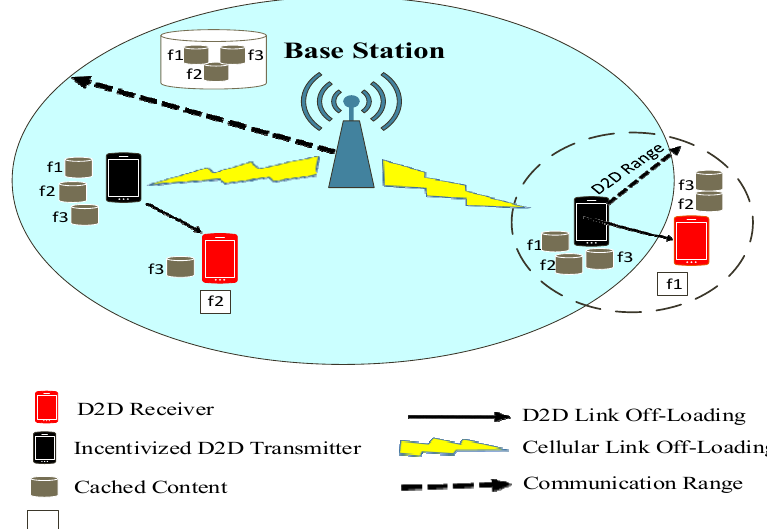
Figure 2. Formation of squeezed cluster in proximity of ID2DTs.